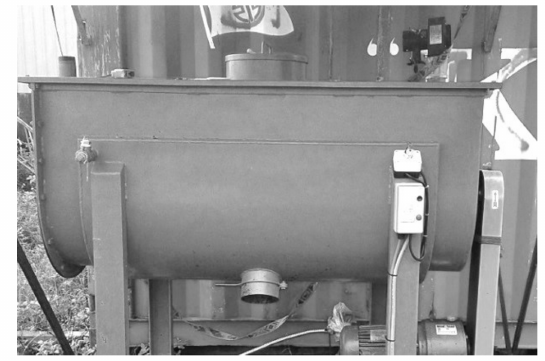
Figure 9. Prototype picture of system.